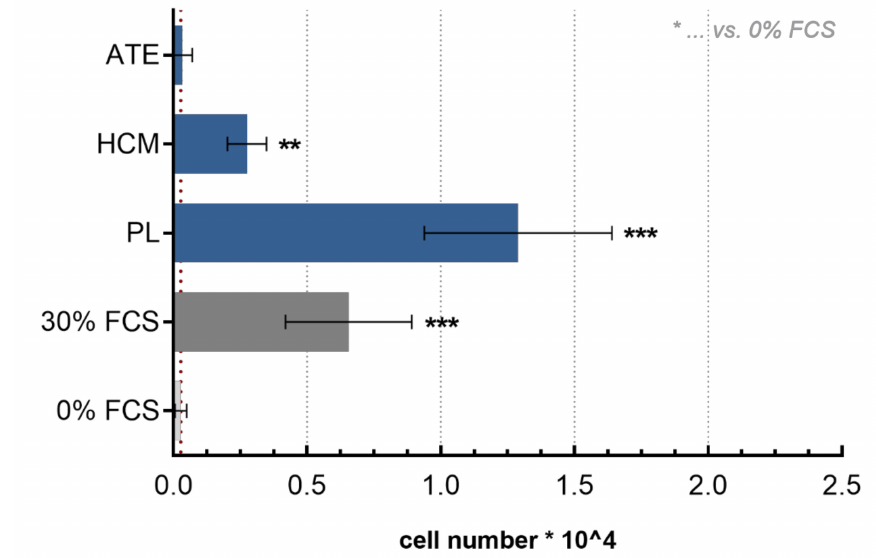
Figure 2. Transwell migration assay. Number of migrated bone-marrow-derived mesenchymal stem cells (BM-MSC) after 24 h incubation as determined by lactate dehydrogenase (LDH) activity measurement (mean ± SD, n = 12; ** p < 0.01, *** p < 0.001). Compared to the positive control (ctrl + osteogenic supplements (OS)), culture medium containing 10% FCS), addition of 10% of all three growth factor mixtures to the medium (culture medium contained no additional FCS) led to a significantly decreased proliferation of BM-MSC during a 14-day cultivation period (Figure 3A). HCM + OS and ATE + OS were significantly inferior to PL + OS in this respect.